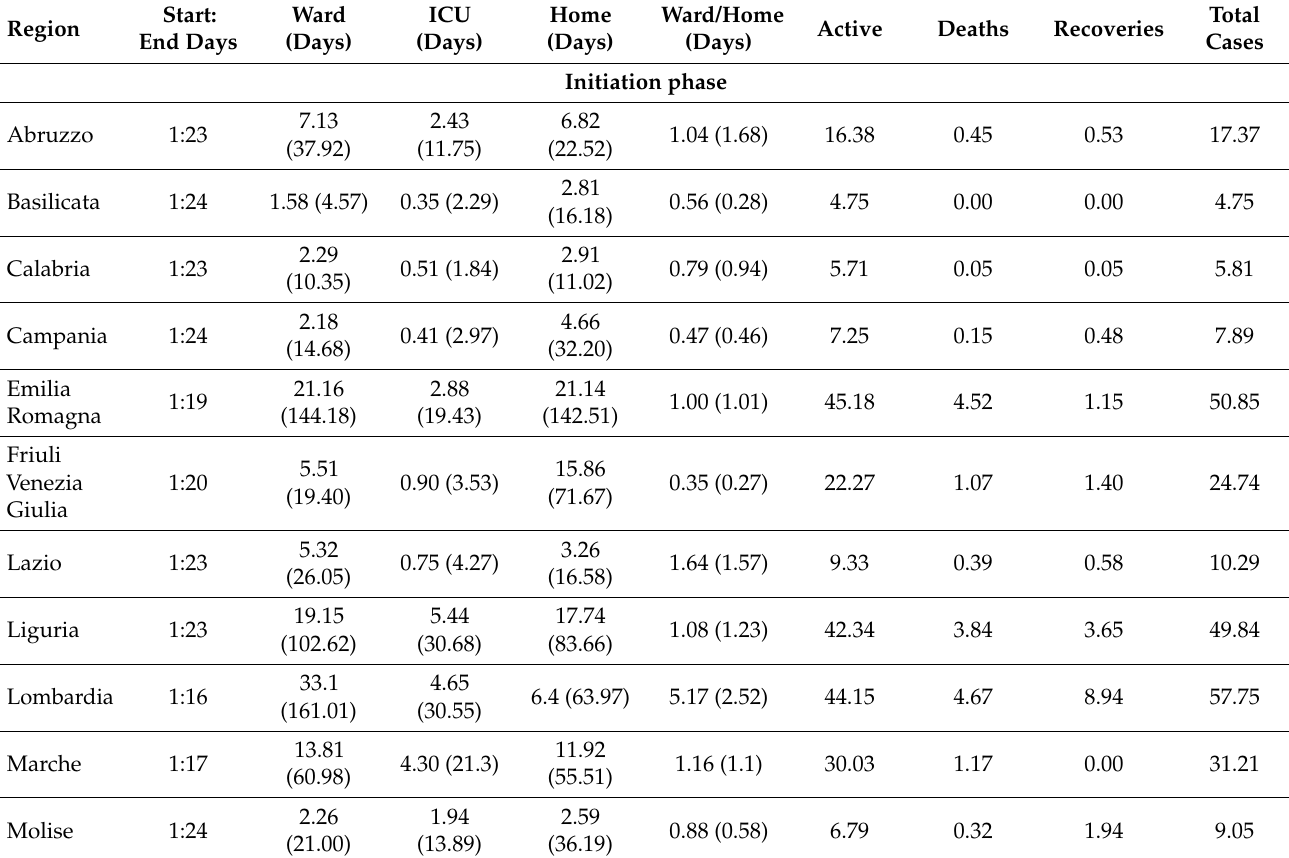
Table A1. Measures captured during the three phases of the epidemic. Data are normalized per 100,000 inhabitants. In particular: the number of patients treated in the hospital (ward), ICU and confined at home along with the relevant total number of days spent by the patients; the ratio between the number of ward and home cases; number of active cases, deaths and recoveries; cumulative number of